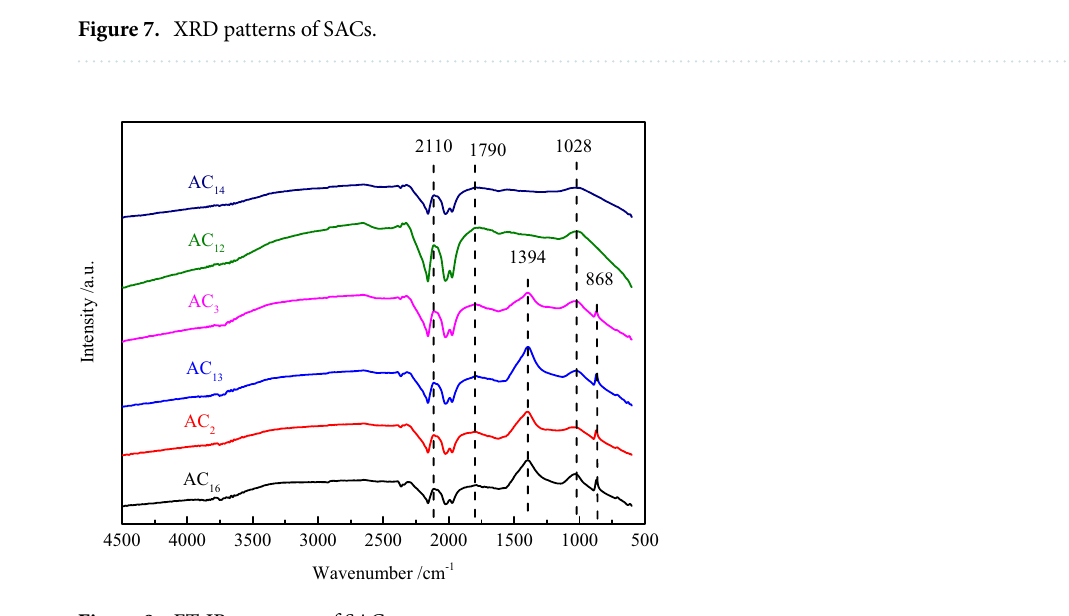
Figure 8. FT-IR spectrum of